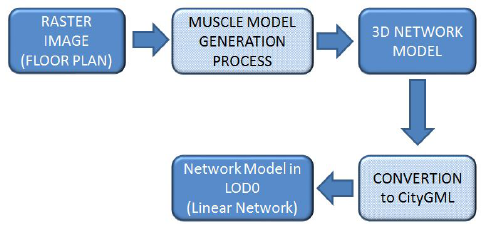
Figure 1. Data Generation